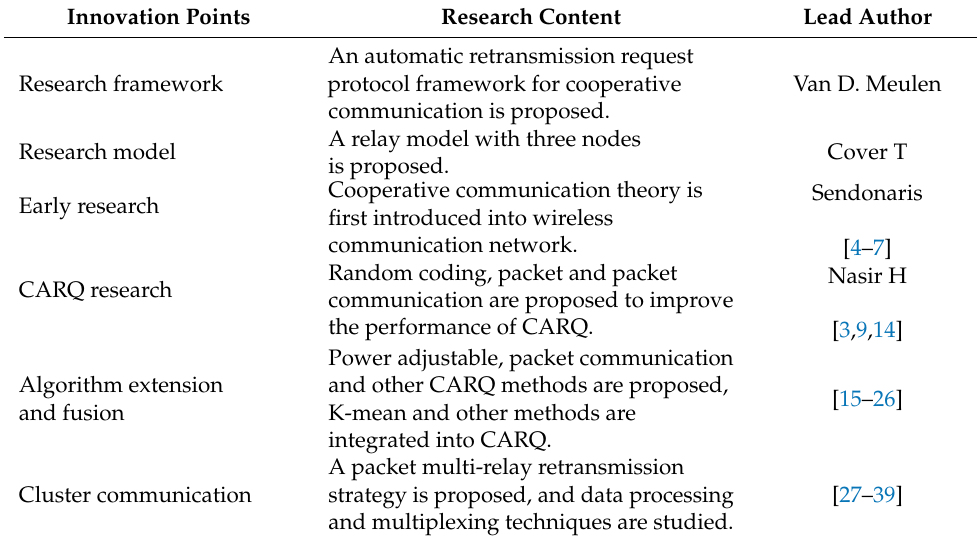
Table 1. A comparison of classical literature on automatic retransmission request strategies for cooperative